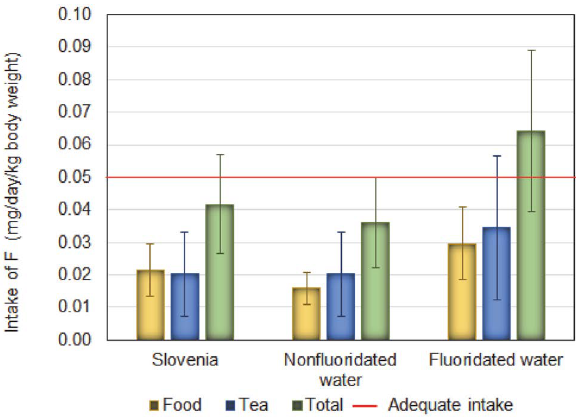
Figure 7: Estimated average total daily intake of fluoride in adults from food and tea in Slovenia and areas with nonfluoridated and fluoridated